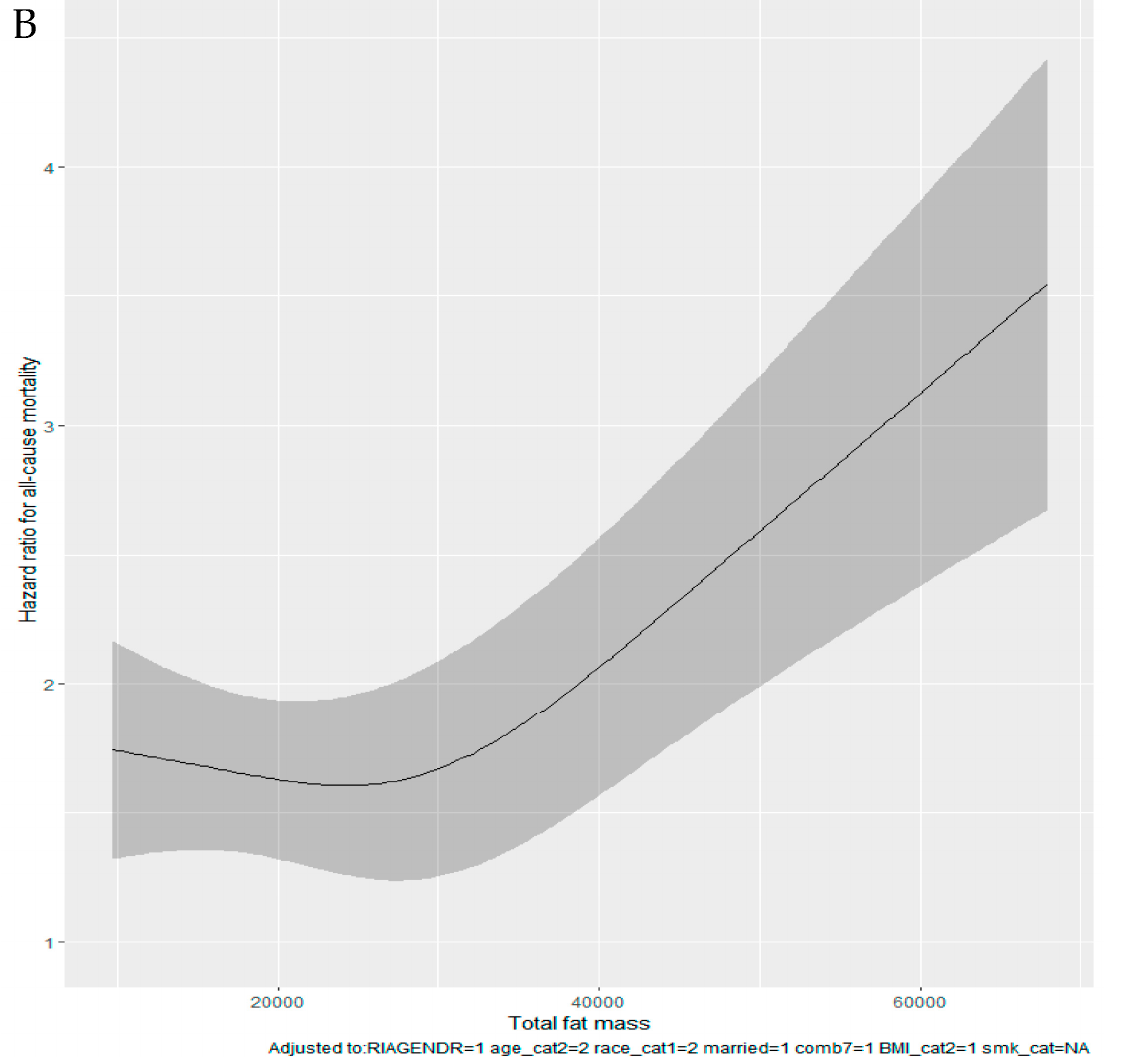
Figure 3. ( A ) Spline functions with corresponding 95% CIs from Cox proportional hazards regression for the relations of sarcopenia; ( B ) Spline functions with corresponding 95% CIs from Cox proportional hazards regression for the relations of total fat mass.